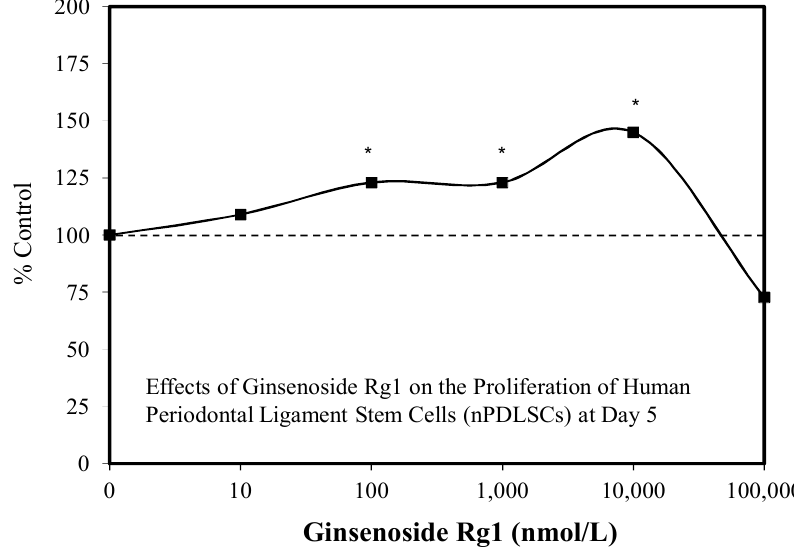
Figure 7. Effects of ginsenoside Rg1 on the proliferation of human periodontal ligament stem cells (nPDLSCs) at Day 5 (Source: [37]). Each * represent statistical significance for a data